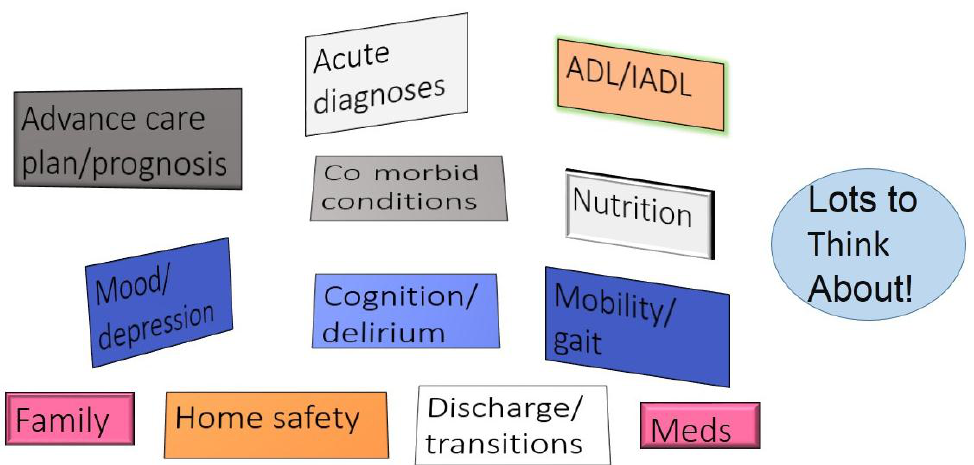
Figure 1. Complexity of hospitalized older adults. Acute care for elders provides structure to the assessment of older adults during hospitalization.